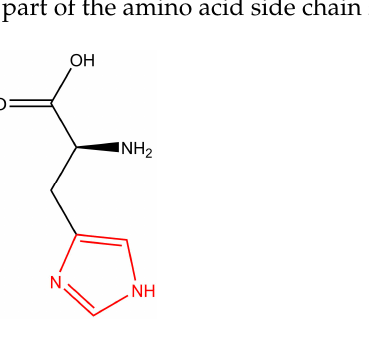
Figure 8. The amino acid histidine with the imidazole group (red) as part of the side chain. Choi et al. demonstrated the binding of a His 6 -tagged peptide to the nickel surface of Ni-Au